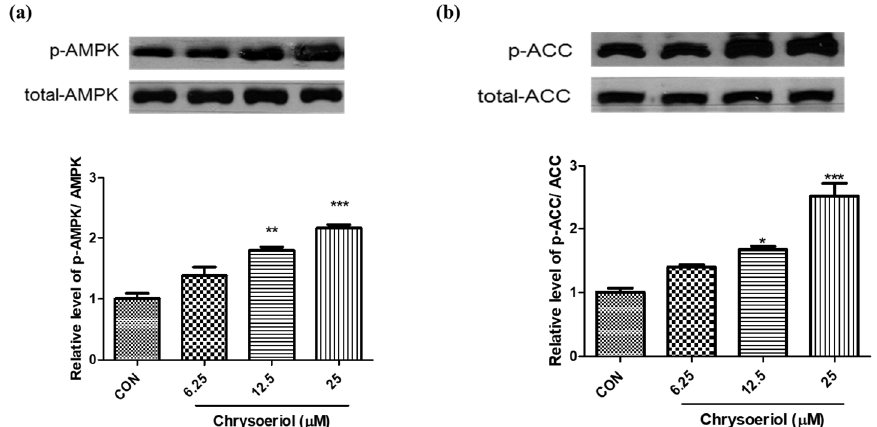
Figure 5. Effects of chrysoeriol on monophosphate-activated protein kinase (AMPK) ( a ) and acetyl- CoA carboxylase (ACC) ( b ) phosphorylation in 3T3-L1 adipocytes. *, **, *** p < 0.05, 0.01, and 0.001, respectively, significant difference compared with control group. CON, control (differentiated cells).